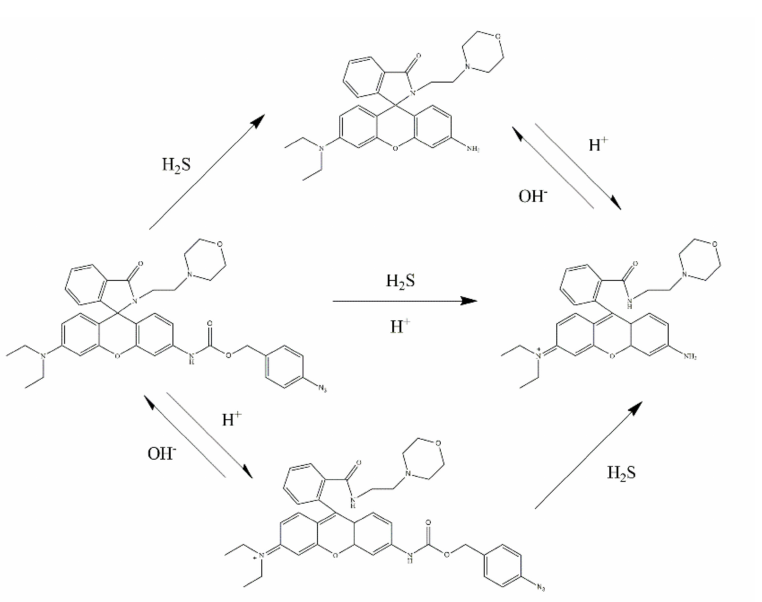
Figure 59. The sensing mechanism of MF-N 3 (Table 4, No. 10) for dual-response to H 2 S and protons